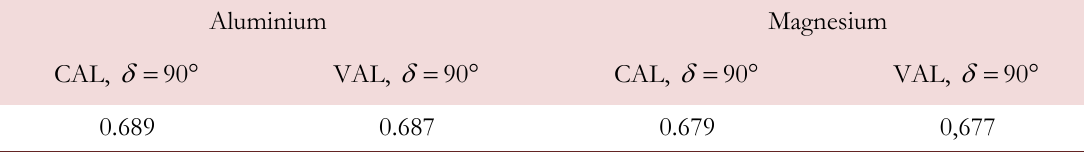
Table 5: Non-proportionality factor according to Gaier, d